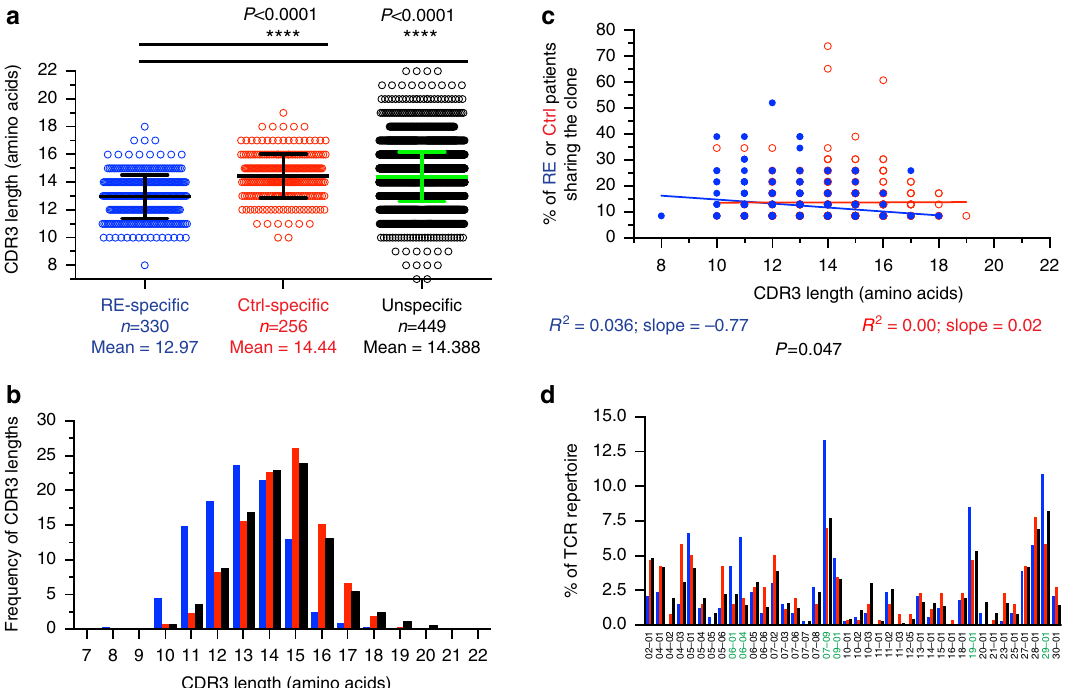
Figure 4 | RE-specific clones share shorter CDR3 regions and V b genes. ( a ) Shown is the mean CDR3 length (in amino acids) of the previously defined groups of clones (RE-specific, n ¼ 330; Ctrl-specific, n ¼ 256 (only found in control patients), and unspecific, n ¼ 4,498 (found, but not shared between either one RE patient, one control patient or in one of each)) (mean ± s.d., unpaired t -test with Welch’s correction). ( b ) CDR3 length distribution of RE-specific (blue), Ctrl-specific (red) and unspecific (black) clones. ( c ) Correlation between the CDR3 length (in amino acids) of the previously described groups of clones and the percentage of RE patients (blue) or controls (red), who shared this clone. Lines indicate the linear regression (analysis of covariance). ( d ) V b genes of the previously described groups of clones. Over-expressed V b genes in RE-specific clones are highlighted in green. Ctrl,